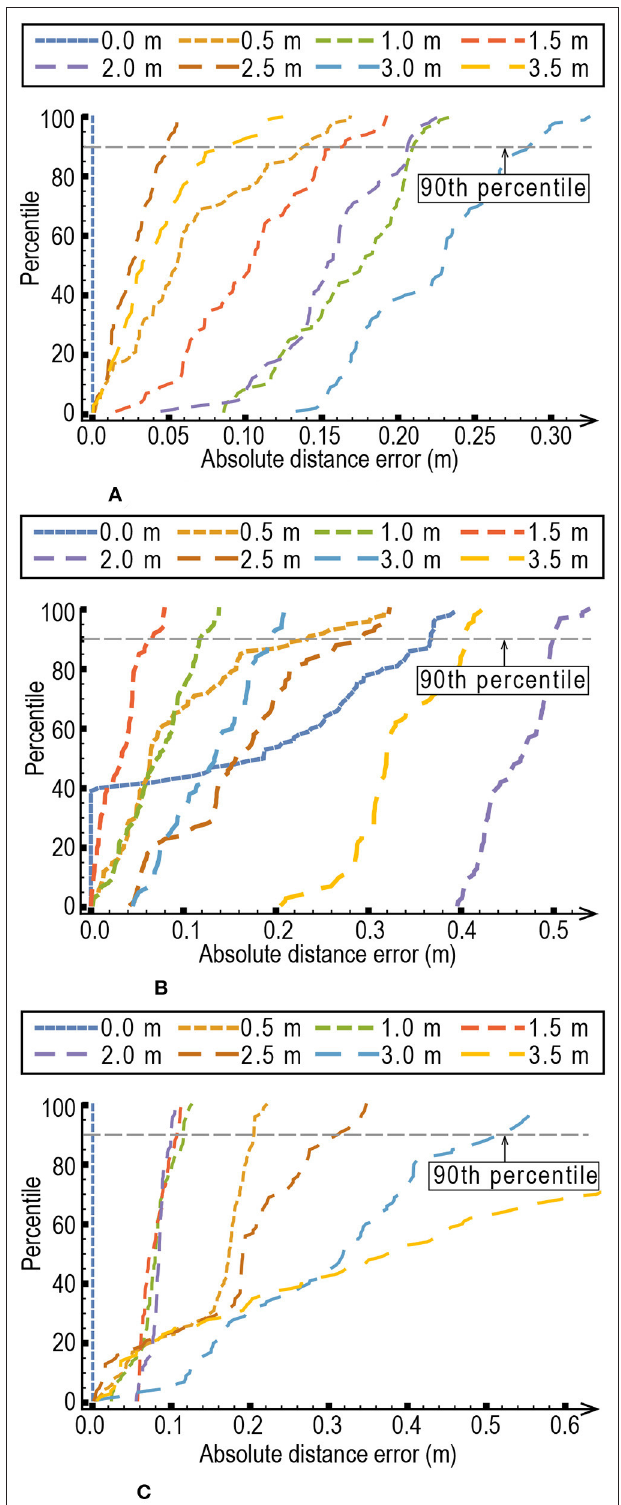
FIGURE 8 | CDF of absolute errors of estimated distance in different ambient light settings. (A) Without direct sunlight in daytime. (B) Direct sunlight in daytime. (C) Fluorescent light in